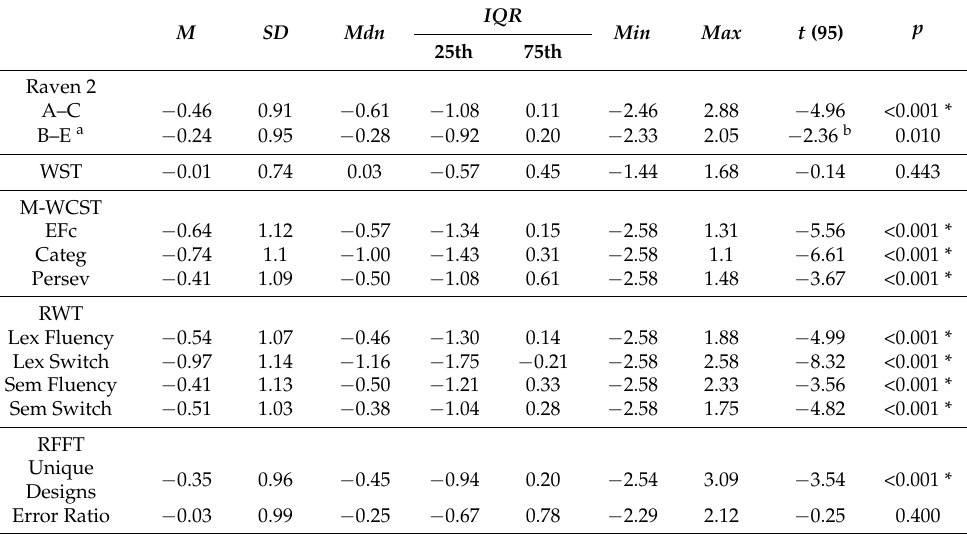
Table 3. Standard scores ( z ) from n = 96 neurological